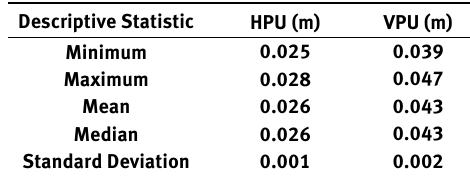
Table 6. Descriptive statistics for HPU and VPU, calculated based on the NRTK baseline network for 56 adjusted